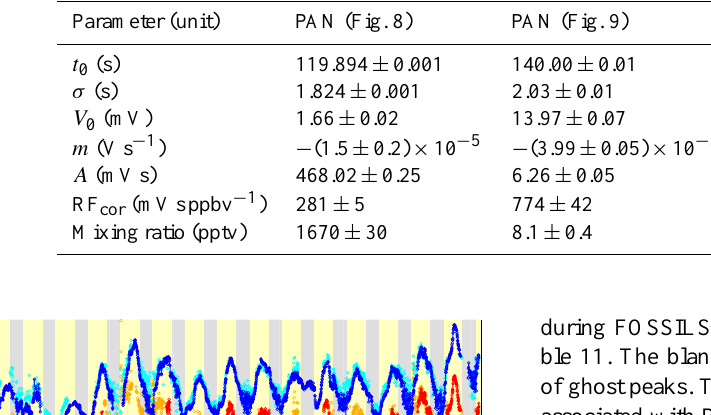
Table 10. Parameters of Eq. (1) fitted to the chromatograms in Figs. 8 and 9.